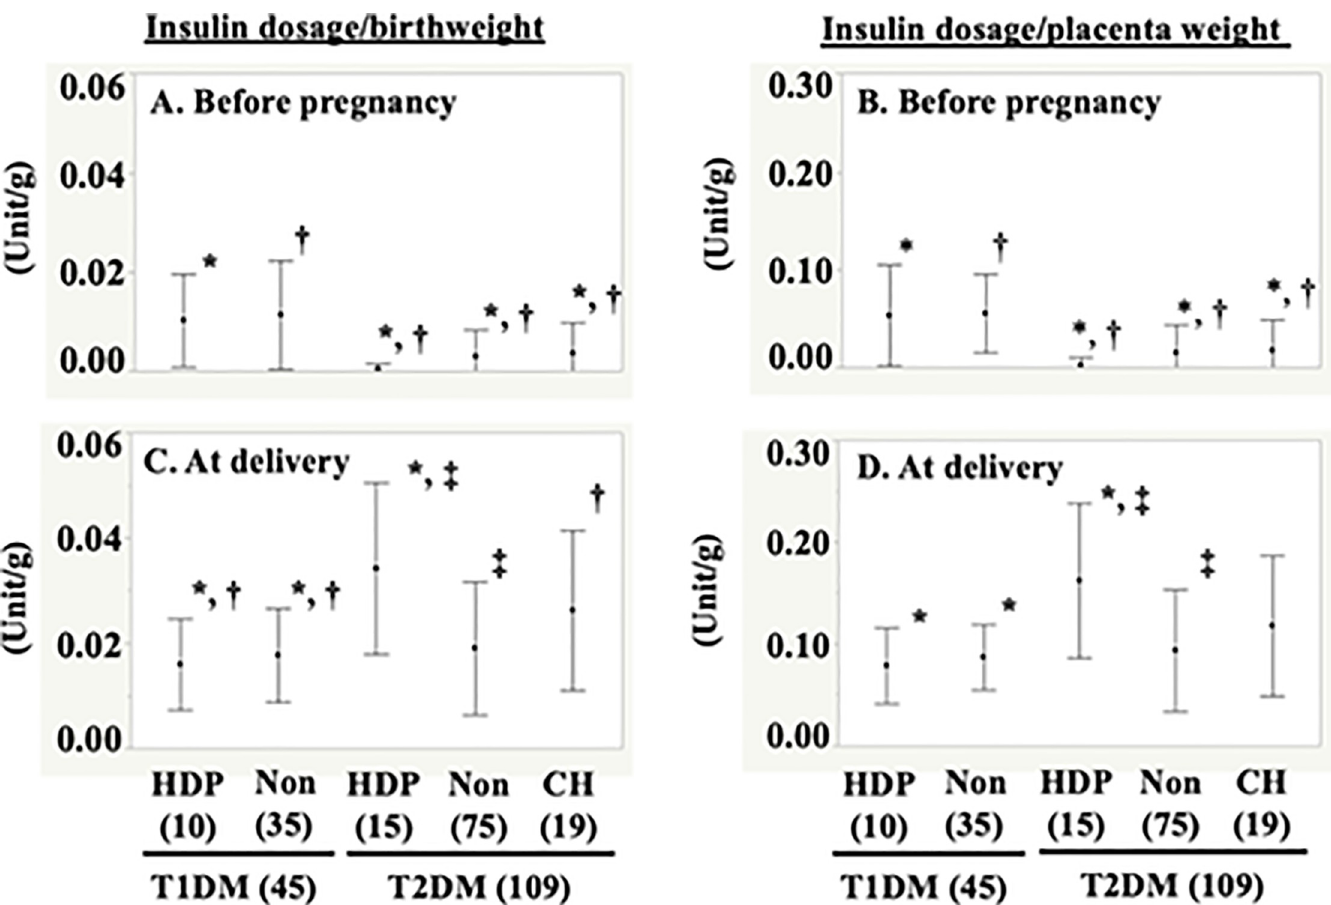
Fig 3. Relationships between fetal weight, placental weight, and insulin dosage before pregnancy and at delivery among women with HDP or CH. (A) Insulin dosage before pregnancy/fetal weight ratios. (B) Insulin dosage before pregnancy/placental weight ratios. (C) Insulin dosage at delivery/fetal weight ratios. (D) Insulin dosage at delivery/placental weight ratios. Abbreviations: HDP; hypertension disorder of pregnancy, Non; without hypertension disorder of pregnancy, CH; chronic hypertension. a p < 0.05 versus women with T1DM, b p < 0.05 versus women with T1DM, and c p < 0.05 versus women without HDP among women with T2DM.